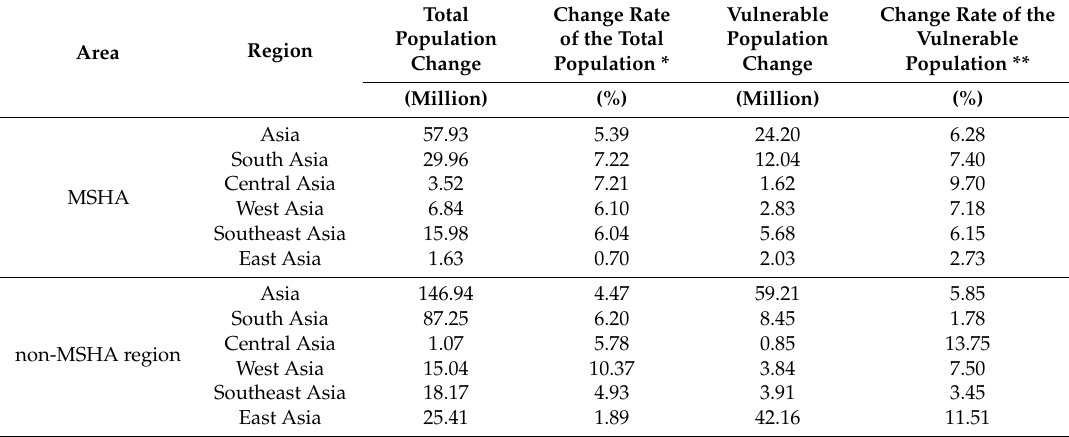
Table A5. Expected changes in the total population and in the vulnerable population of Asia from 2015 to